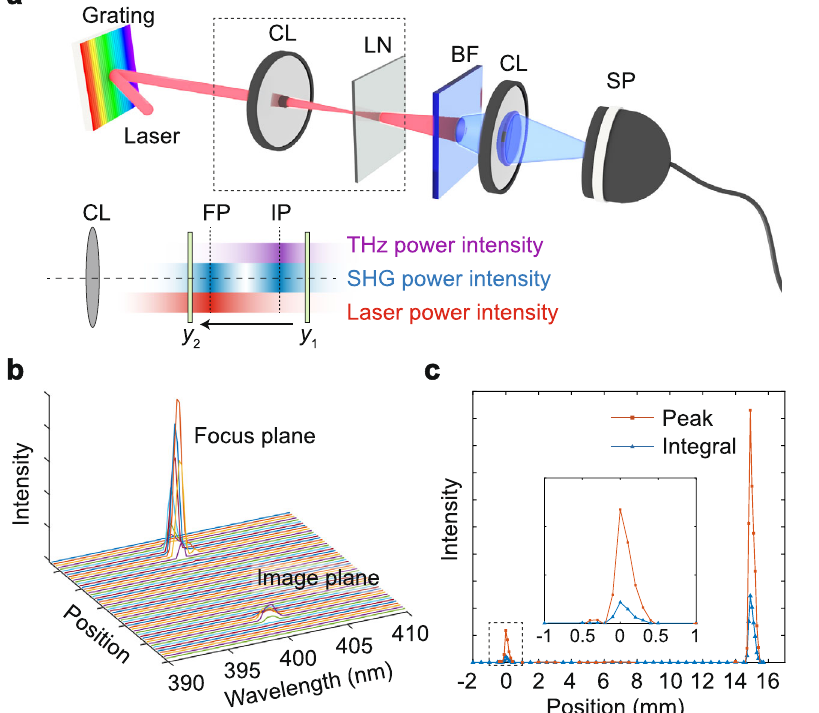
Fig. 5 Second-harmonic generation (SHG) enhancement of near-infrared laser pulses due to the stimulated phonon polariton-mediated light – matter interaction. a Experimental setup for excitation of the stimulated phonon polaritons and the measurement of SHG signal of infrared laser pulses. CL: convex lens; LN: lithium niobate slab; BF: blue fi lter; SP: spectrometer; FP: focus plane; IP: image plane. b Spectra of the SHG signal obtained by moving the LN slab. c Peak intensity and the total energy of the SHG signal when the sample is moved. The inset shows the details of the peak value near the image